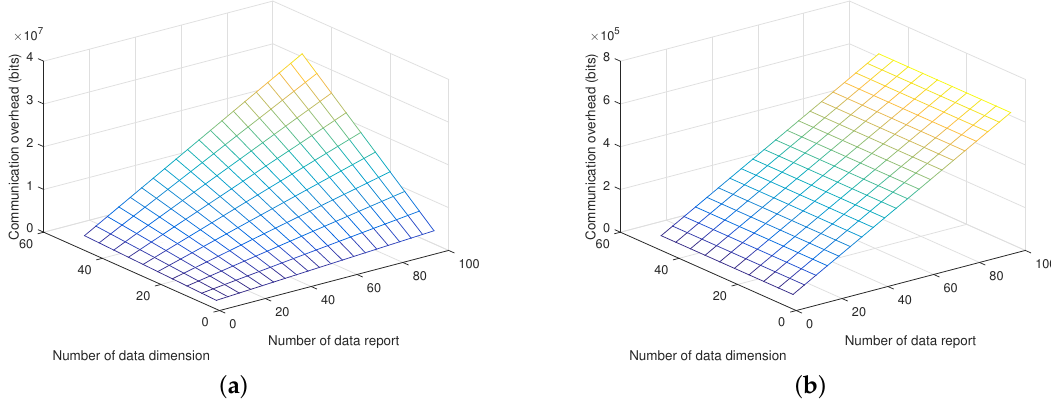
Figure 7. Vehicles to data server communication overhead. ( a ) Communication overhead of vehicles during data uploading with the traditional scheme; ( b ) Communication overhead of vehicles during data uploading with the proposed